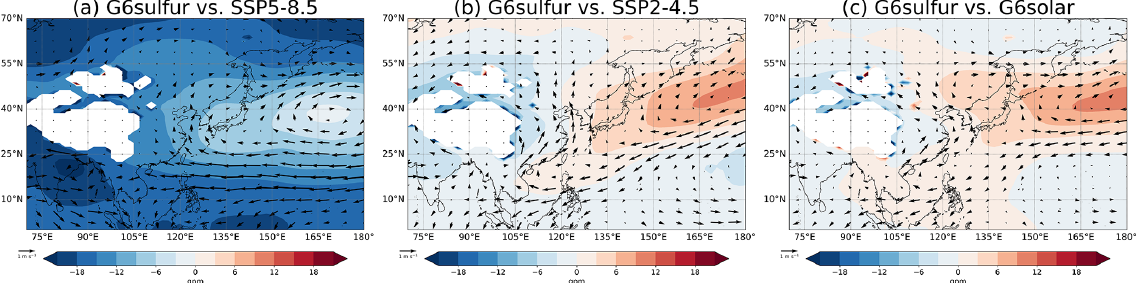
Figure 2. Differences in MJJAS mean geopotential height (shaded) and wind (vectors) at 850hPa for the future period of 2071–2100 between G6sulfur and SSP5–8.5 (a) and SSP2–4.5 (b) and G6solar (c)